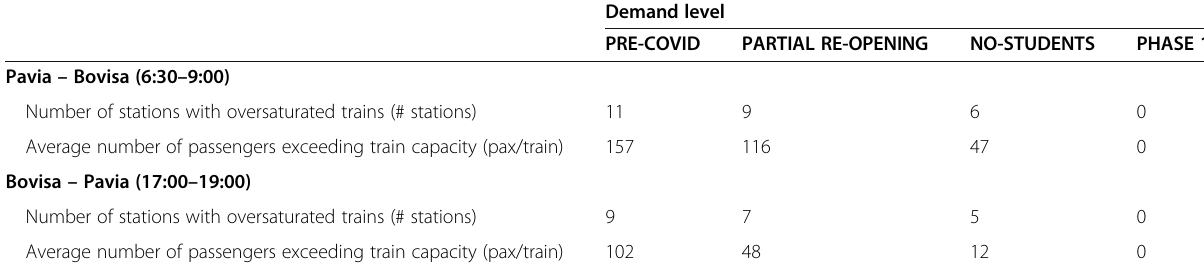
Table 1 Outputs of the scenario simulations with capacity restrictions (i.e. 270 passenger/train) under different assumptions of demand levels